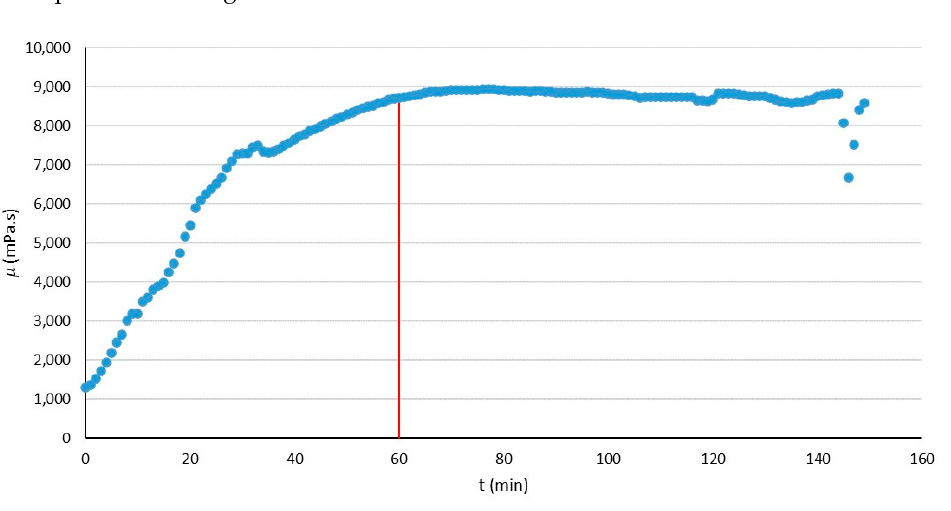
Figure 6. Viscosity during the homogenization process.